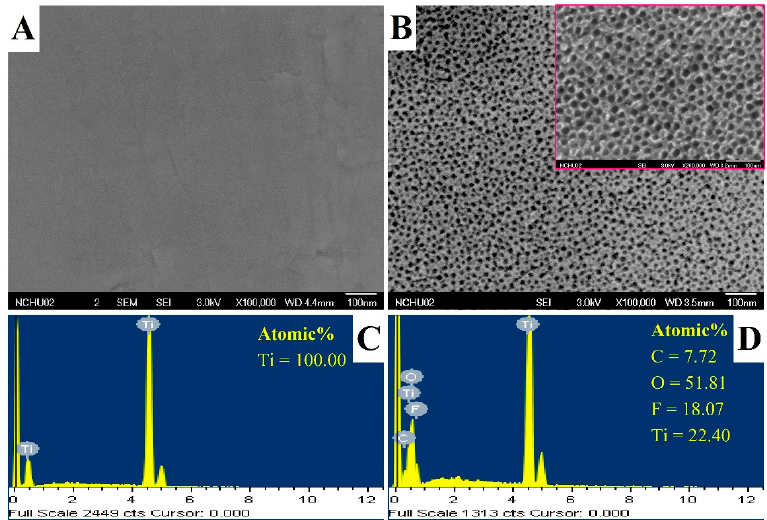
Figure 2. The surface morphology and composition of the ( A,C ) pure titanium and ( B,D ) titanium dioxide nanotube (TNT) as observed by FE ‐ SEM and EDS, respectively. The red frame is a magnified image of the